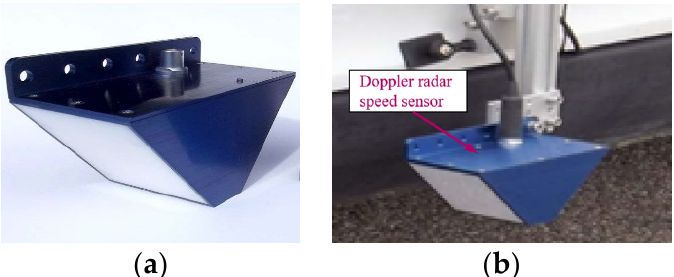
Figure 4. Doppler radar speed sensor and installation example: ( a ) doppler radar speed sensor; ( b ) installation example. Figure 5. The block diagram of the proposed method.